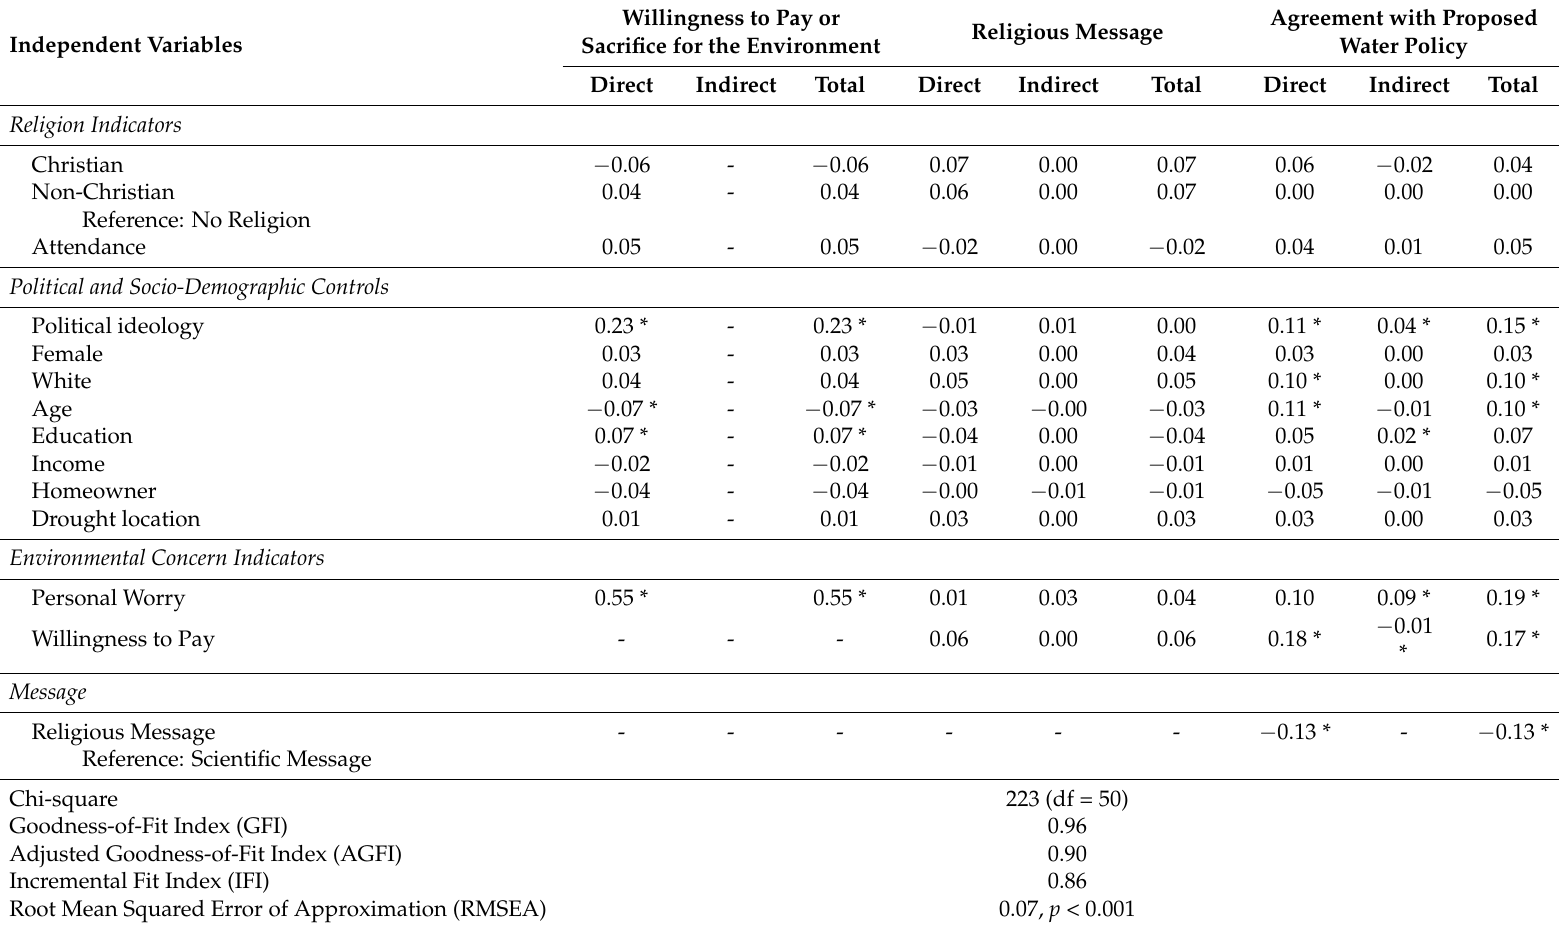
Table 2. Standardized coefficients from structural equation model predicting agreement with proposed water policy, entire sample (N = 608). Willingness to Pay or Independent Variables Sacrifice for the